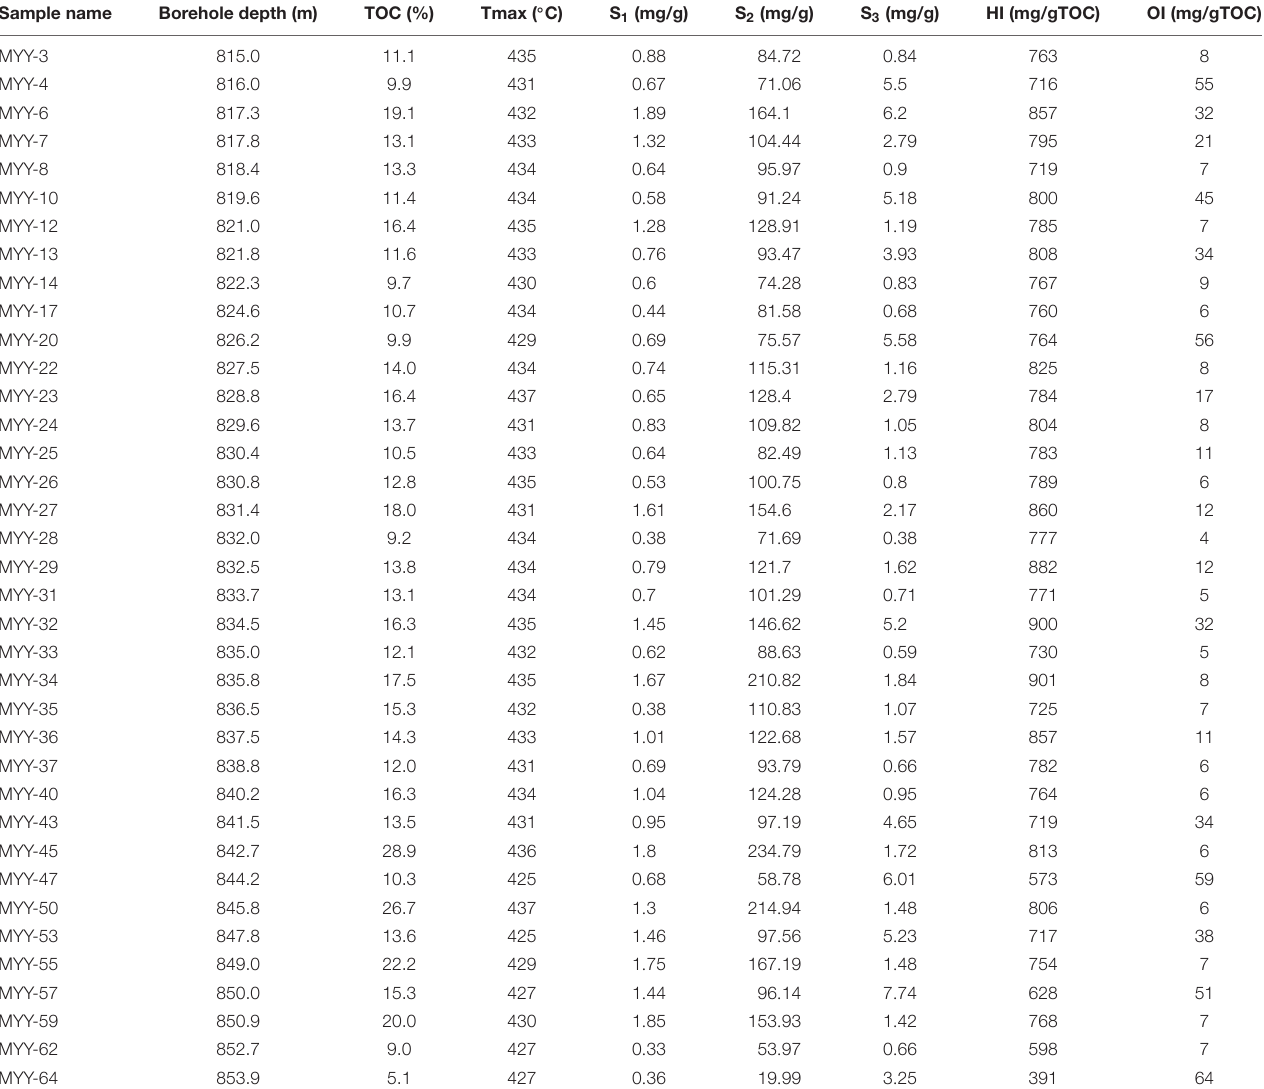
TABLE 1 | Sampling information and the pyrolytical data of Maoming oil